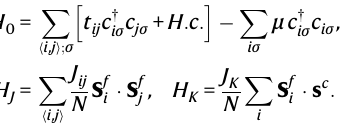
Fig. 3 | Electrical resistivity and the scaling. a , b The resistivity ρ ( T ) of Ce 1 − x Nd x CoIn 5 with x =0.02 and x =0.05, respectively, for B ∥ c . The insets of a , b show the Fermi-liquid behavior with ρ ( T )~ T 2 electrical resistivity at low tem- peratures for B =90 kOe. c , d The T / B scaling of both a and b show an universal function linearly proportional to T / B (black solid lines). y ρ is a non-universal ( fi eld- dependent) constant, satisfying y (cid:2) 1 ρ ½ ρ ð T Þ(cid:2) ρ 0 (cid:5) = T = B . e , f The scattering rates ℏ / τ for x =0.02, 0.05 at the intermediate temperature regime where the electrical